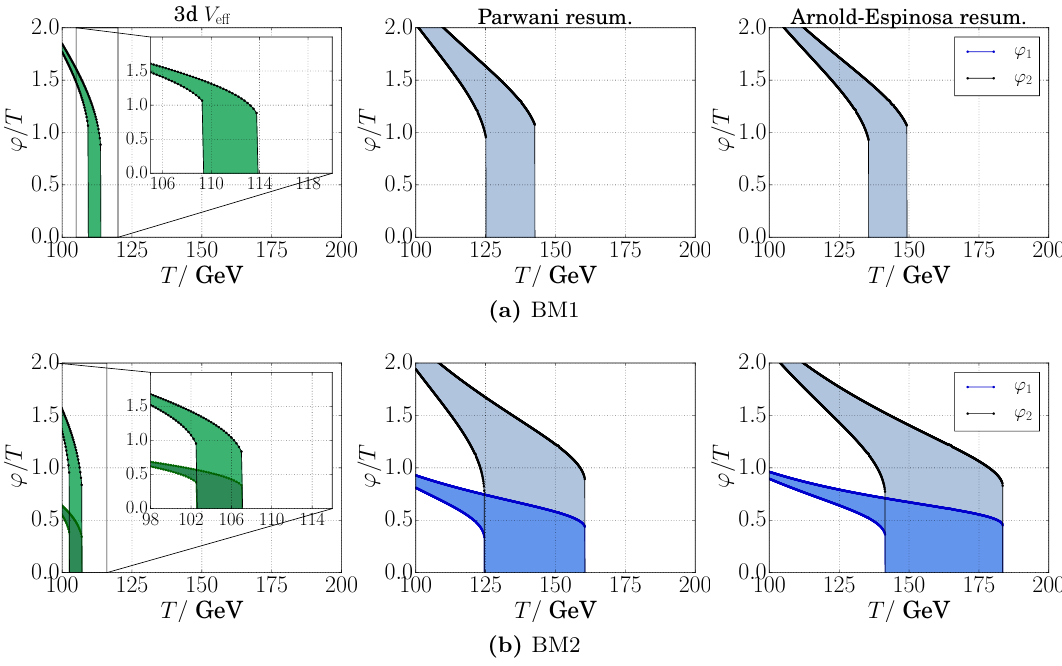
Figure 11. Location of the global minimum of the perturbative e(cid:11)ective potential as a function of the temperature. At high temperature, the minimum is at the origin and the electroweak sym- metry is restored. From left to right: 2-loop potential in the 3d EFT, 1-loop V e(cid:11) with Parwani resummation, 1-loop V e(cid:11) with Arnold-Espinosa resummation. Values for two di(cid:11)erent choices of the RG scale are shown, and the coloured band in between illustrates the perturbative uncertainty as described in the text. In BM1, the inert doublet (cid:30) 1 does not develop a VEV due to unbroken Z 2 symmetry.